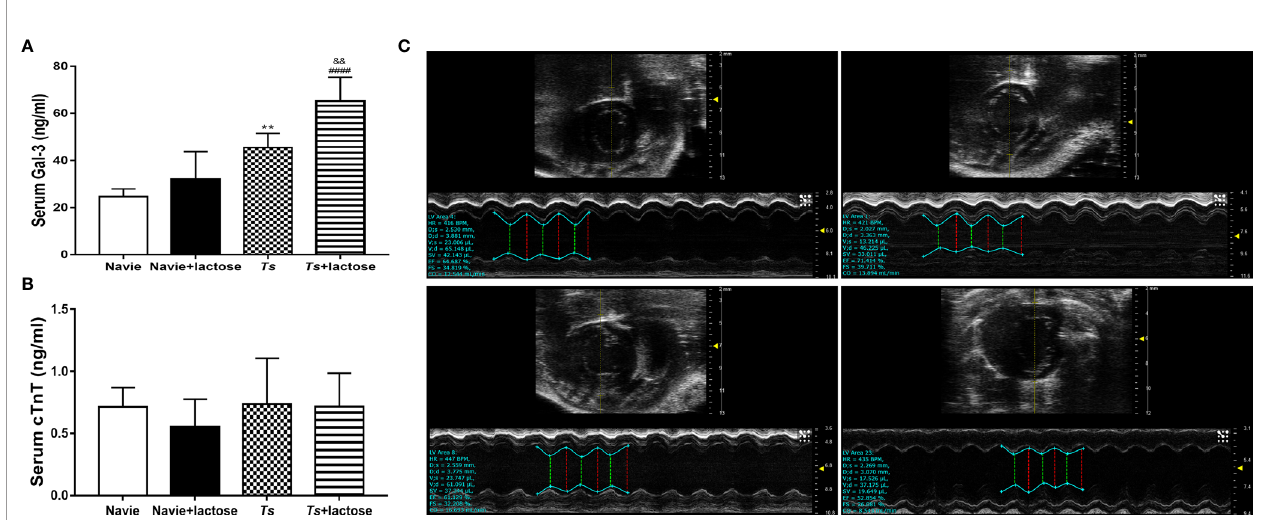
FIGURE 3 | The serum levels of Gal-3 (A) and cTnT (B) , and the M-mode echocardiography (C) of different groups of mice. Uninfected mice (a), uninfected mice with a -lactose treatment (b), T. spiralis -infected mice (c), and T. spiralis -infected mice with a -lactose treatment (d). ** P < 0.01 vs . uninfected mice. #### P < 0.0001 vs . uninfected mice or uninfected mice with a -lactose treatment. && P < 0.01 vs . T. spiralis- infected